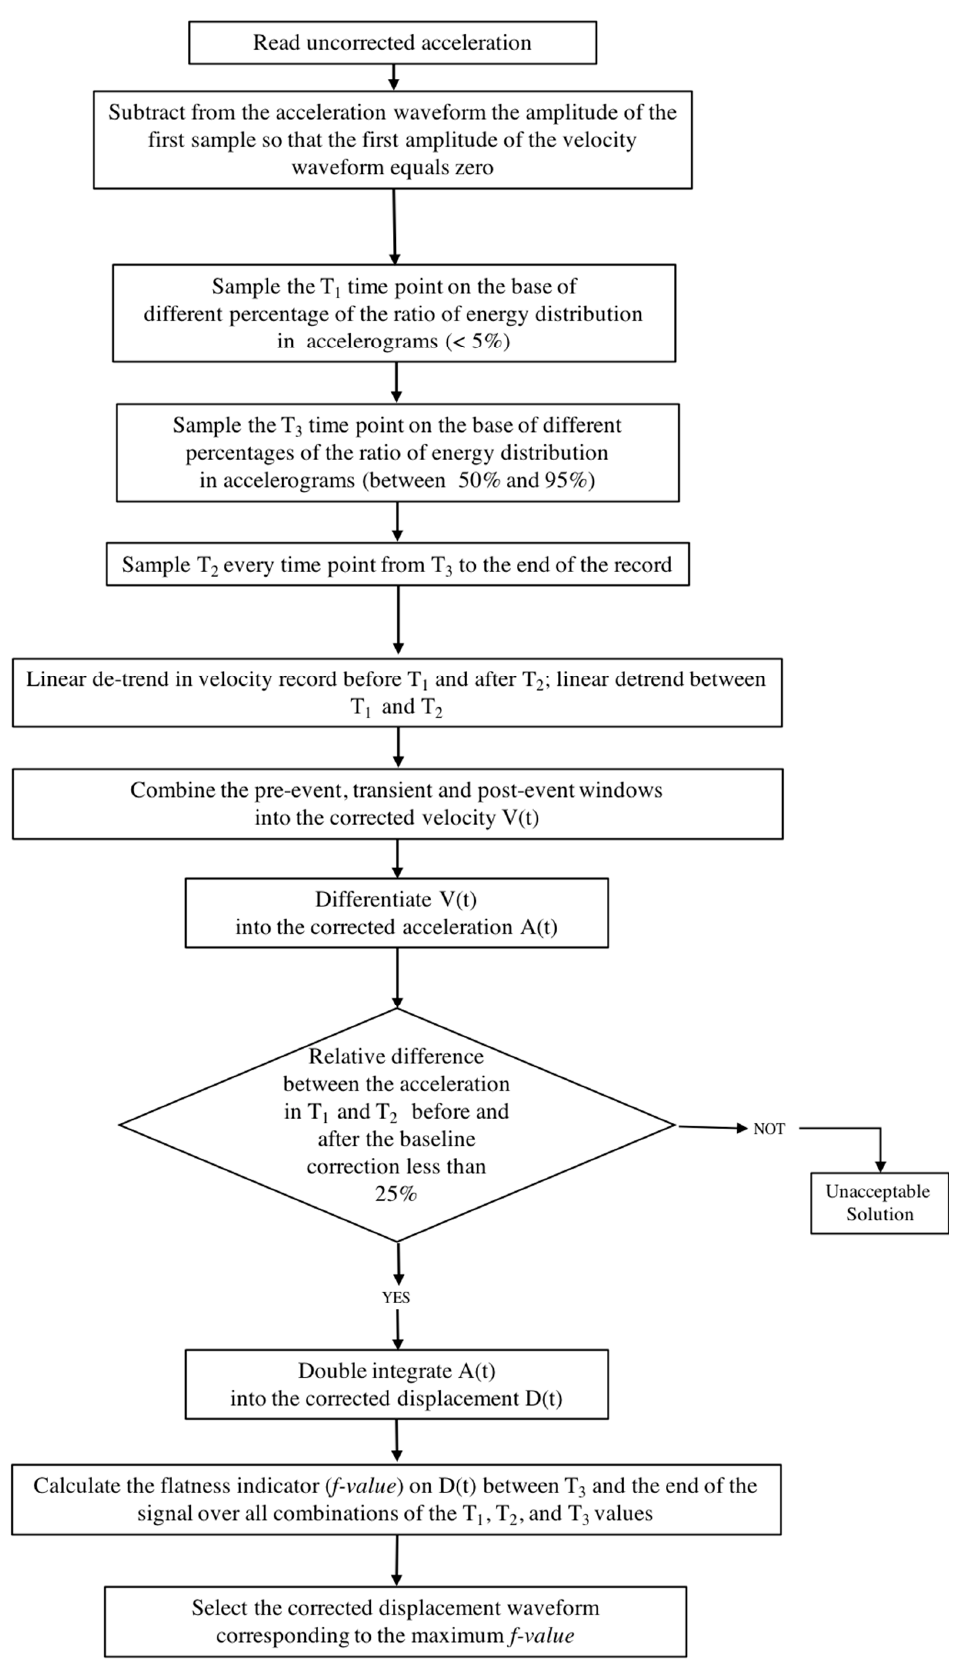
Figure 2. Flowchart of the eBASCO procedure, modified after [9].